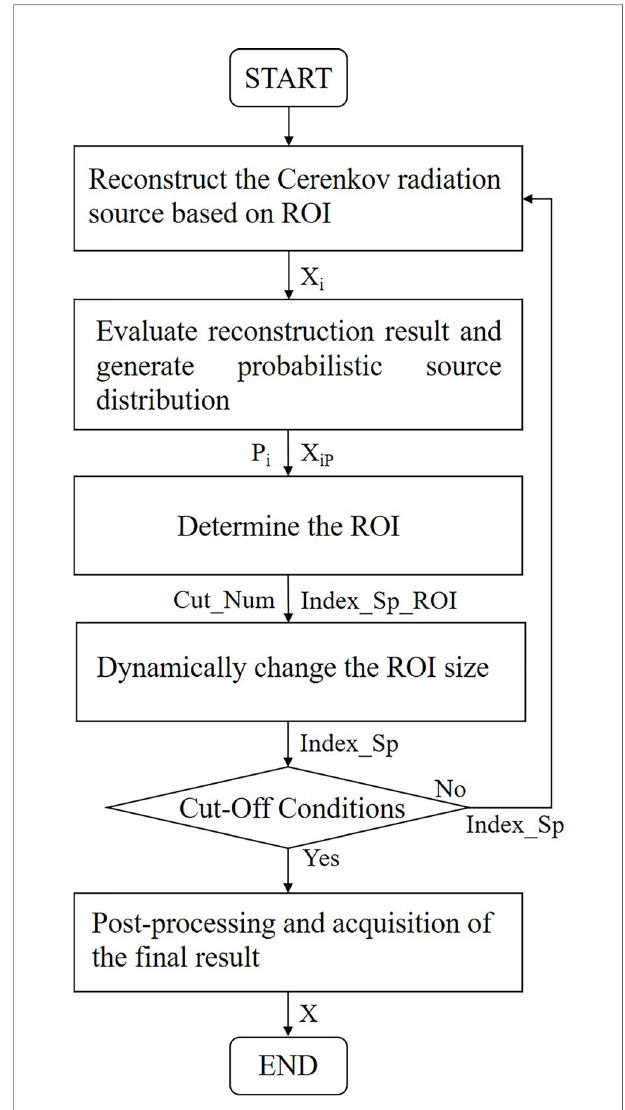
FIGURE 1 | Flowchart of P-EDDRS framework for CLT. P-EDDRS, probabilistic energy distribution density region scaling; CLT, Cerenkov luminescence